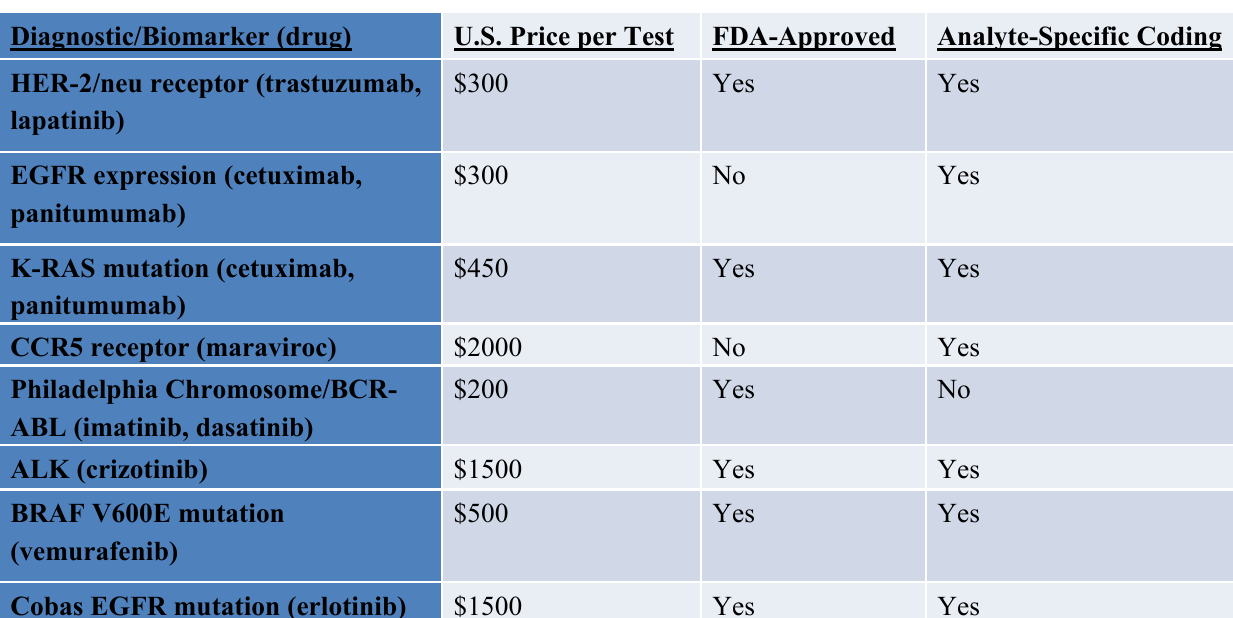
Table 3. Diagnostics/biomarkers.